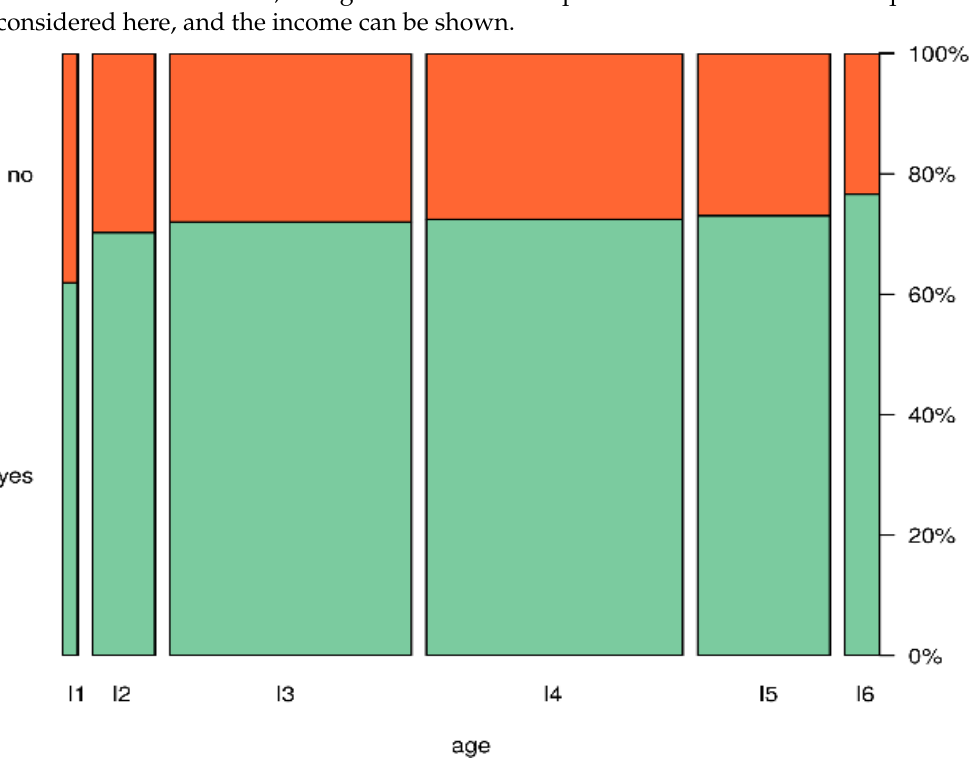
Figure 8. Propensity to track energy use by income.